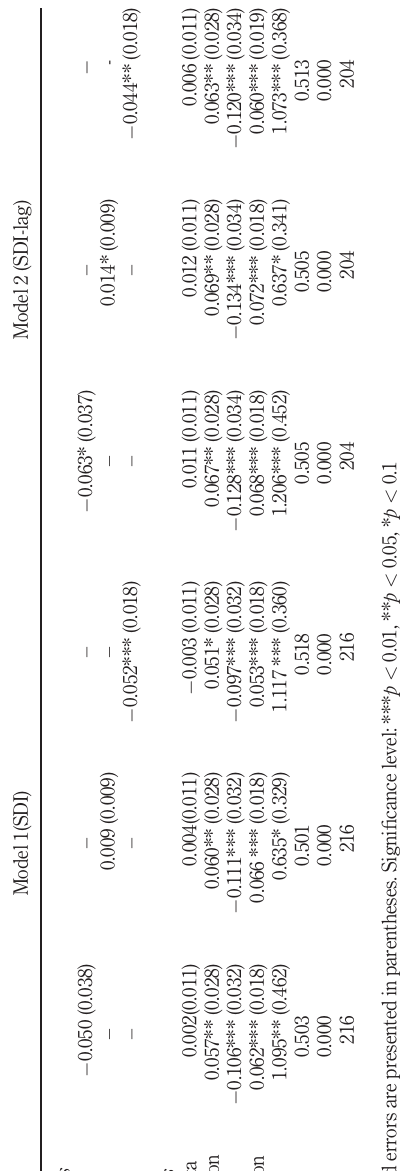
Table 3. Estimated results of farmers ’ cropping strategy under climate